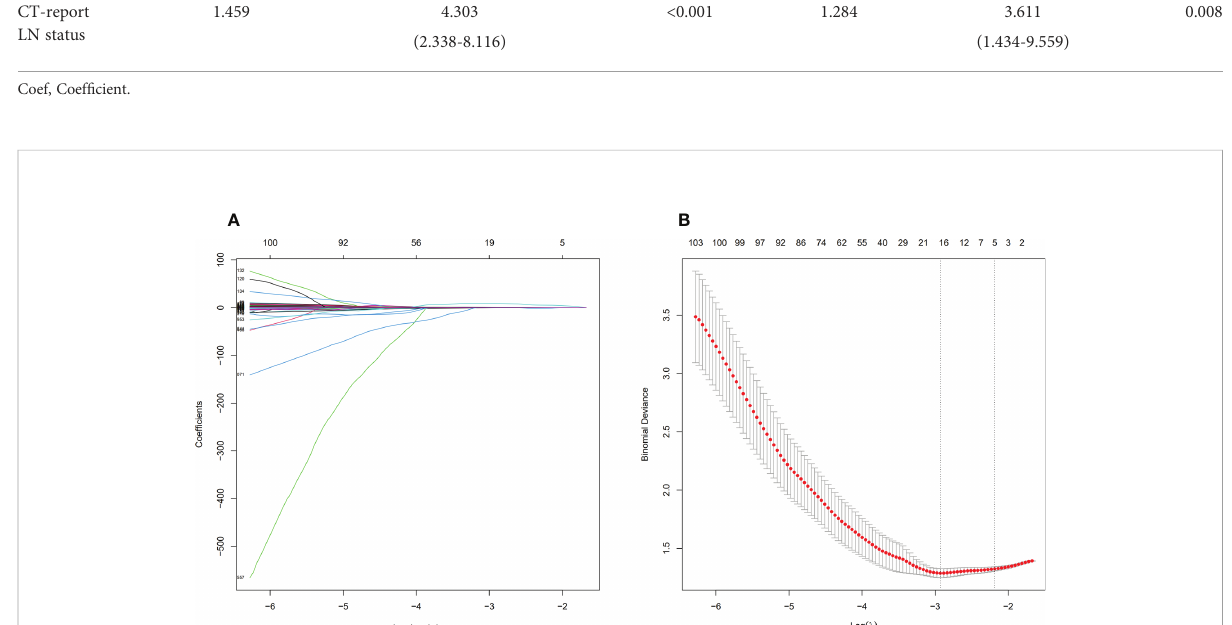
FIGURE 4 Feature selection process by LASSO in NECT. (A) shows the shrinkage diagram of 1216 radiomics features ’ coef fi cients from NECT. (B) shows the 10- fold cross-validation curve, 16 optimal features were chosen based on the lambda.min criteria. LASSO, least absolute shrinkage and selection operator.